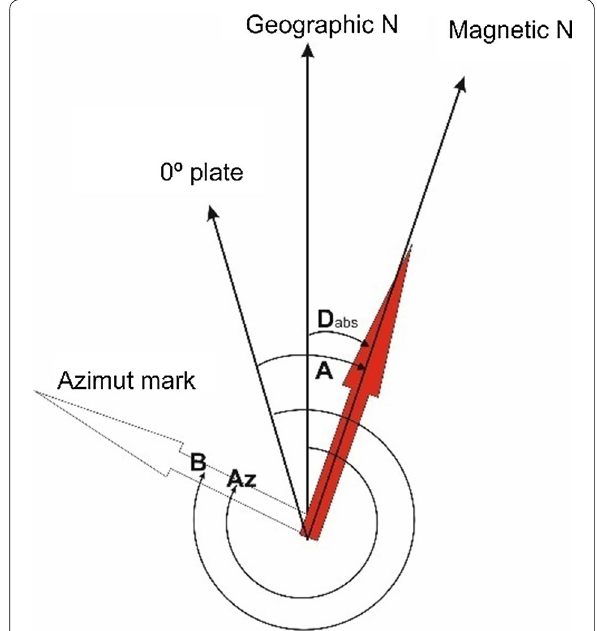
Fig. 3 A presentation of the principle of the measurement of magnetic declination D abs with a declinometer. A is the circle read in the direction of the magnet; N is the direction to geographic north; and B is the circle reading to the azimuth mark, whose azimuth A z is